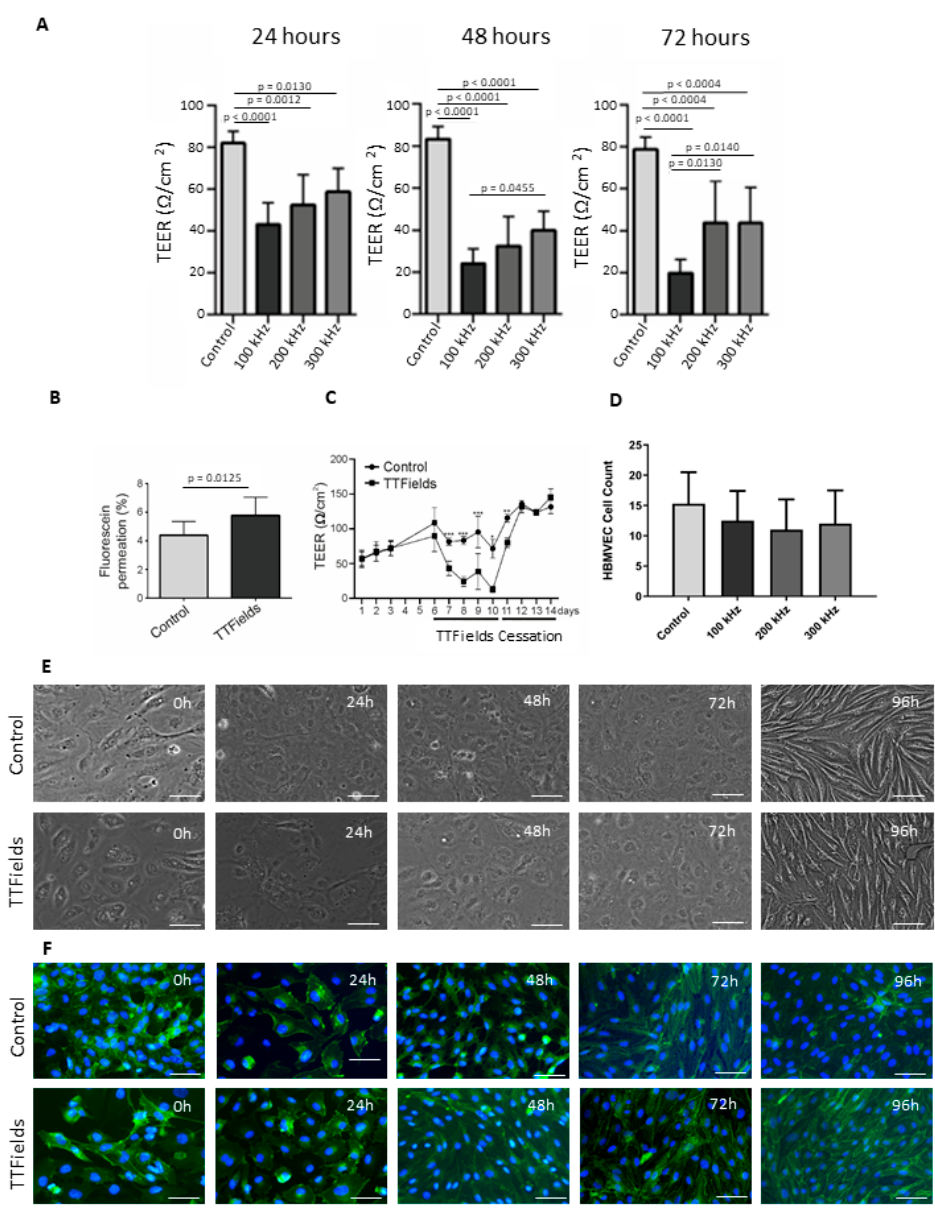
Figure 3. TTFields exhibit transiently diminished barrier integrity and enhanced